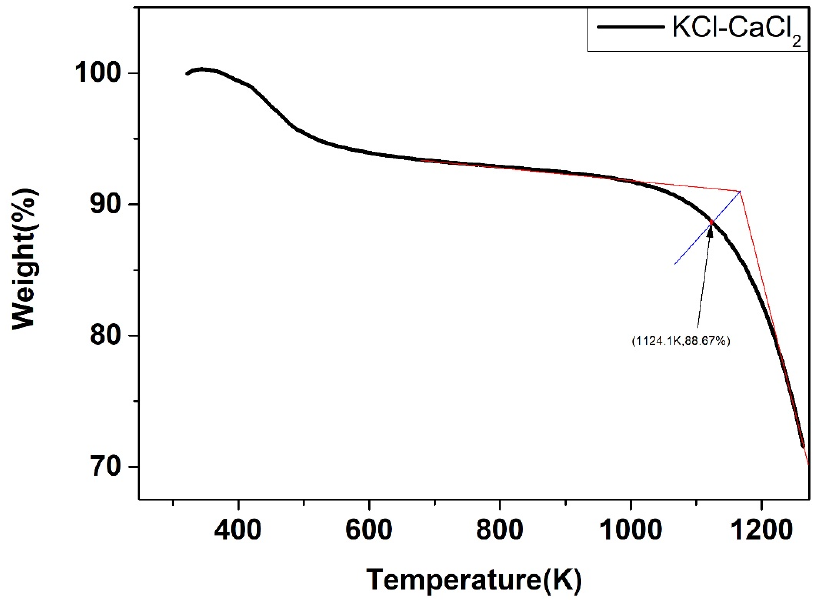
Figure 24. Weight change (wt.%) of the KCl ‐ CaCl 2 binary chloride salt.